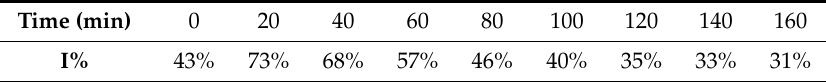
Table 4. Toxicity evolution of HDZ after electrochemical oxidation